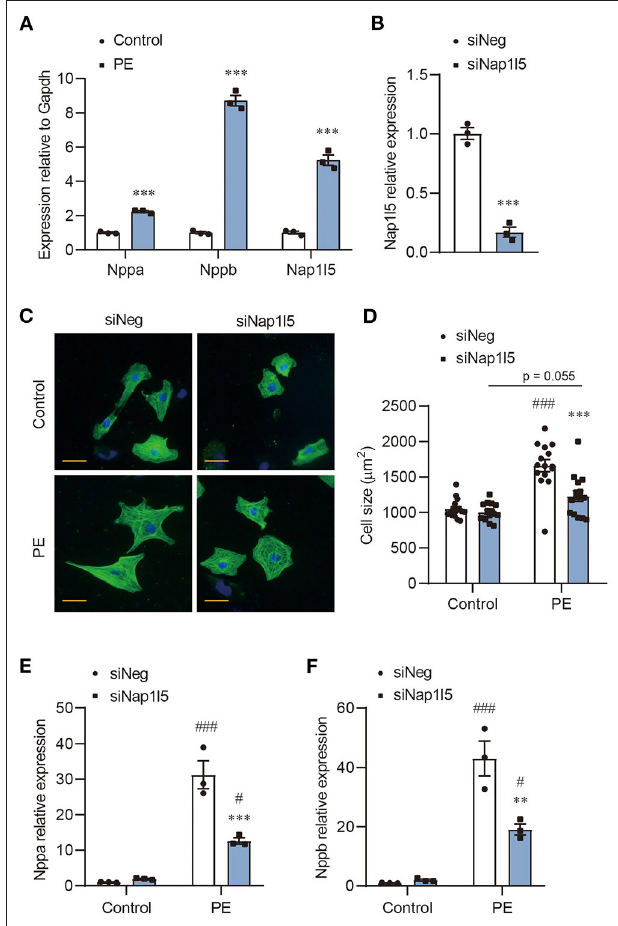
FIGURE 1 | NAP1L5 silence abolishes PE-induced cardiomyocyte hypertrophy. (A) Expression of Nppa, Nppb and Nap1l5 in neonatal rat ventricular myocytes (NRVMs) with and without phenylephrine (PE; 50 µ M) treatment measured by qRT-PCR. *** P < 0.001 vs. Control. n = 3.